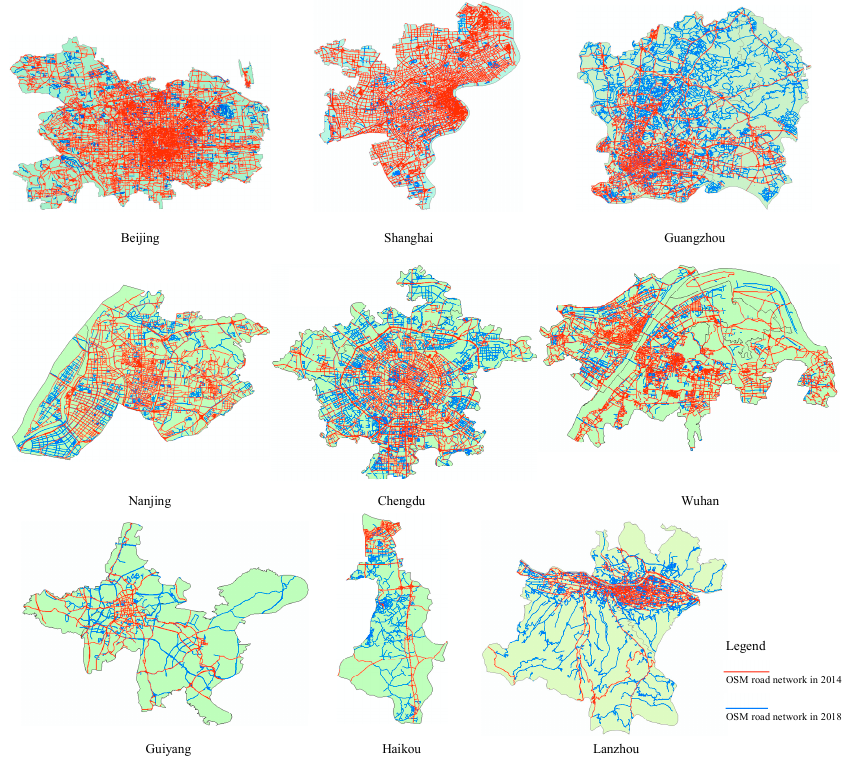
Figure 2. The OpenStreetMap (OSM) road network with three different grades in Chinese cities.